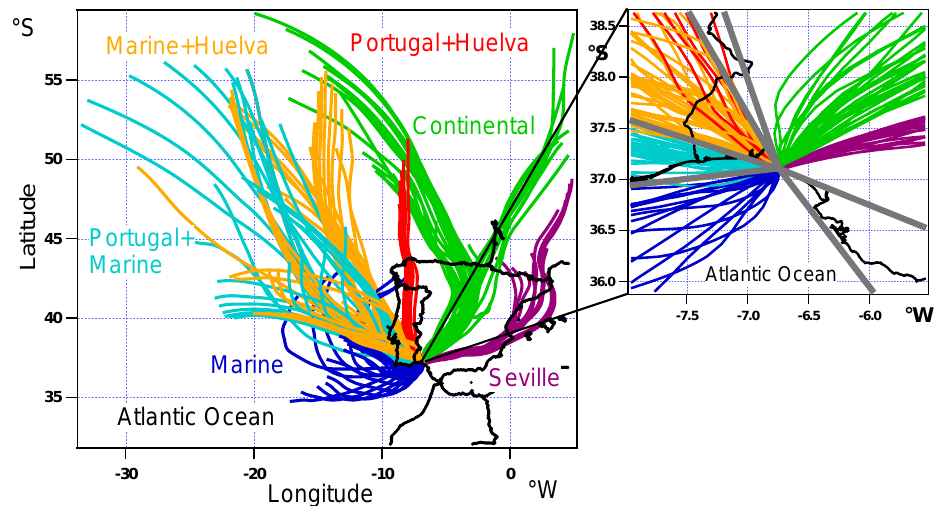
Fig. 2. On the left side, a map of the Iberian Peninsula is shown including 48h backwards trajectories calculated for every 2h using HYSPLIT. The zoom-in at the right shows the transport direction of the classified air mass types at the measurement site. 6 air mass categories corresponding to different source regions were separated: “Seville” (purple), “Continental” (green), “Portugal+Huelva” (red), “Marine+Huelva” (orange), “Portugal+Marine” (light blue), “Marine” (blue).